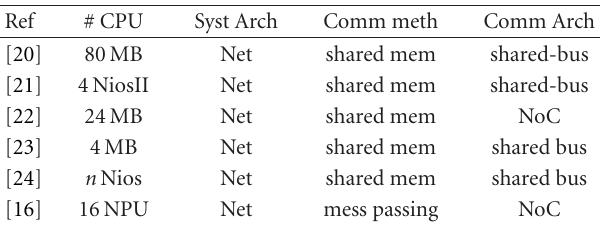
Table 4: Homogeneous FPGA-Based multiprocessor